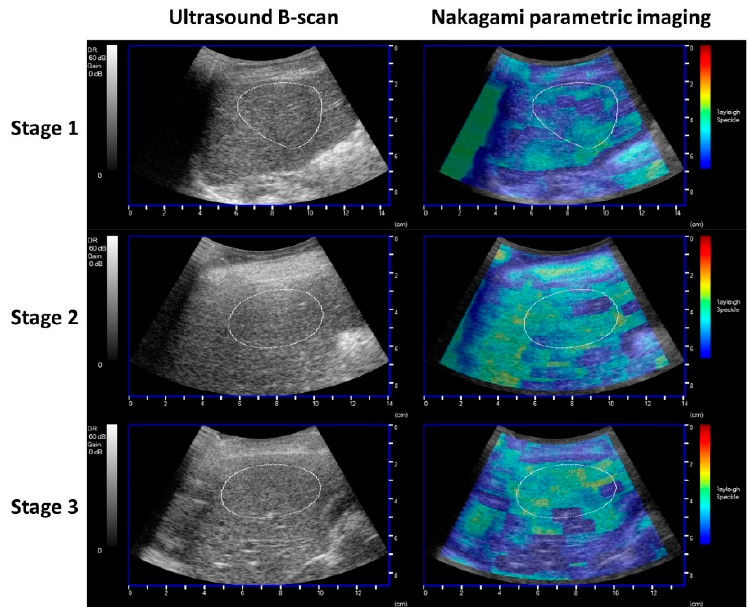
Figure 2. Ultrasound Grayscale B-mode and Nakagami parametric images of the liver in DMD patients at different ambulatory stages (stage 1: ambulatory stage, stage 2: early non-ambulatory stage, stage 3: late non-ambulatory stage). The brightness of ultrasound Nakagami imaging gradually increased with declining ambulatory stage of DMD. The NPI as a measure of hepatic steatosis was obtained by manually outlining the region of interest (ROI) (dotted line) on the Nakagami image for averaging the pixel values.